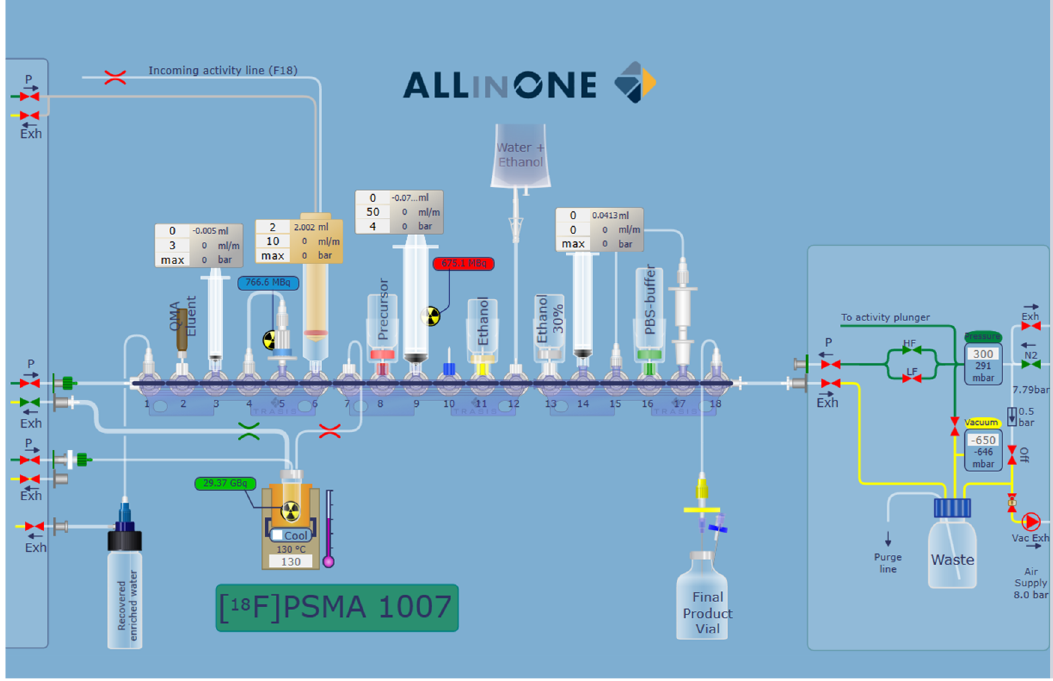
Figure 3. User graphic interface of the synthesis cassette for the preparation of [ 18 F]F-PSMA-1007.